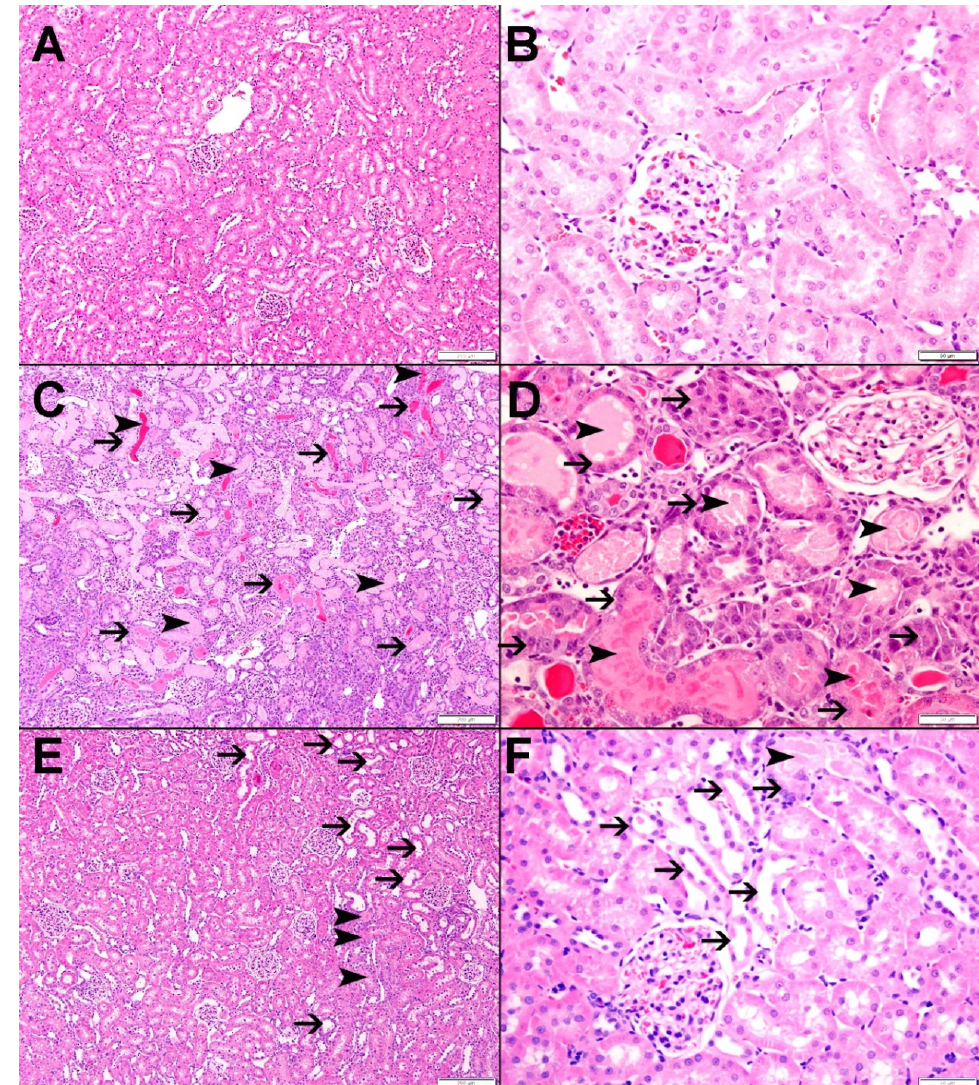
Figure 8. Histological features in all the experimental groups. (A,B) The kidneys in G-Sham showed normal architecture and histology. (C,D) Histological features in the G-IRI with diffuse acute tubular necrosis (thin arrow) and intratubular necrotic material and secretions (arrowhead). (E,F) Histological features in G-IRI/NR with mild acute tubular necrosis and tubular dilation (thin arrow) and intratubular secretion (arrowhead).